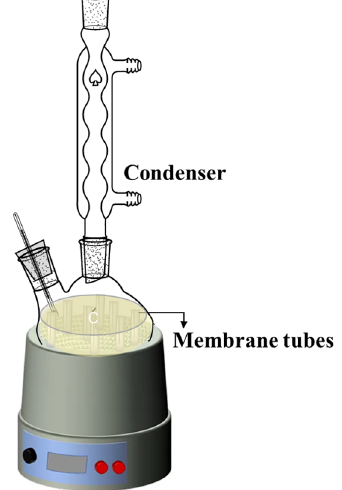
Figure 3. Schematic diagram of stability test.